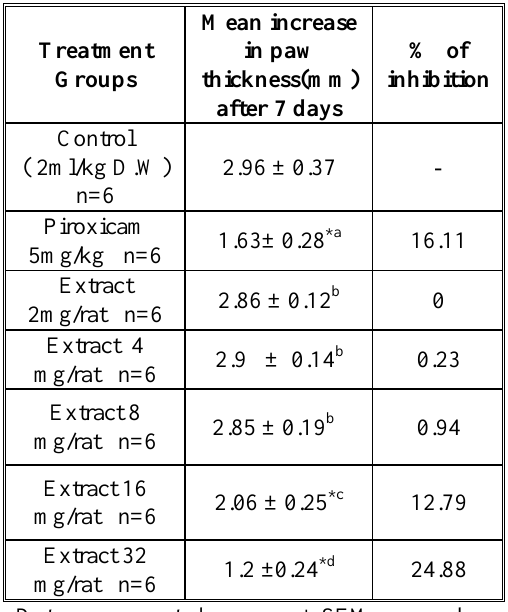
Table 1 : Effect of different doses of Ammi majus alcoholic extract on formalin-induce chronic inflammation in